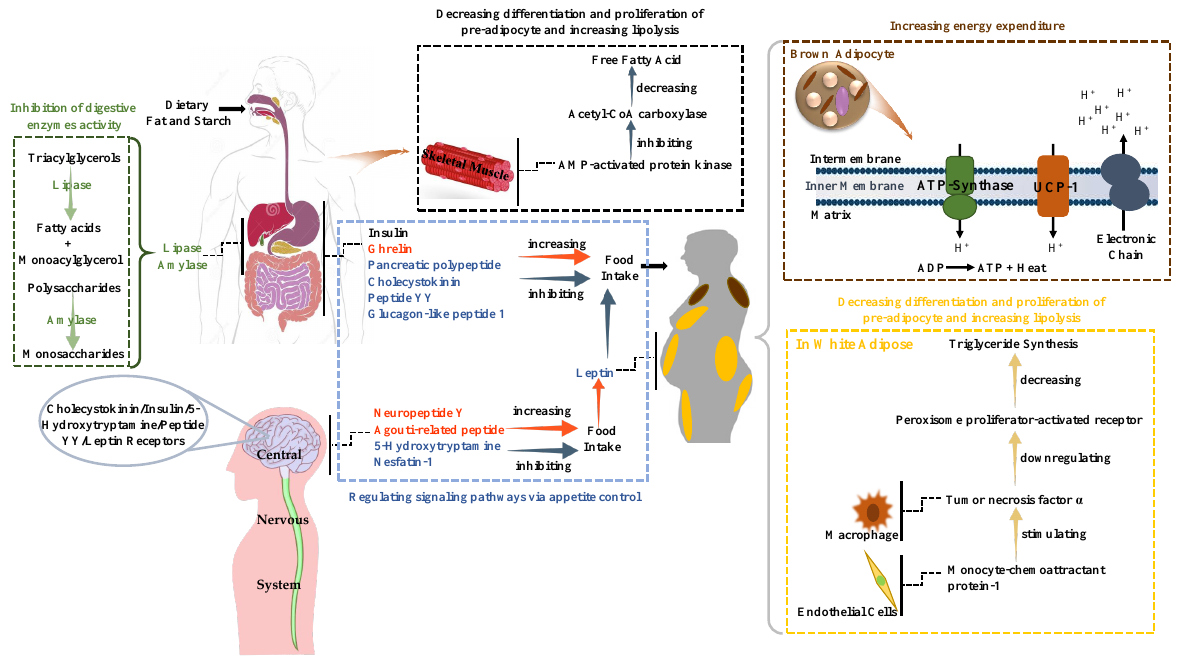
Figure 2. The etiology of obesity and potential corresponding treatment for obesity. Interactions between diet, digestive enzyme, energy intake, modulation of appetite, and the differentiation and proliferation of pre-adipocyte are shown. The orange words represent orexigenic mediators and blue words represent anorexigenic